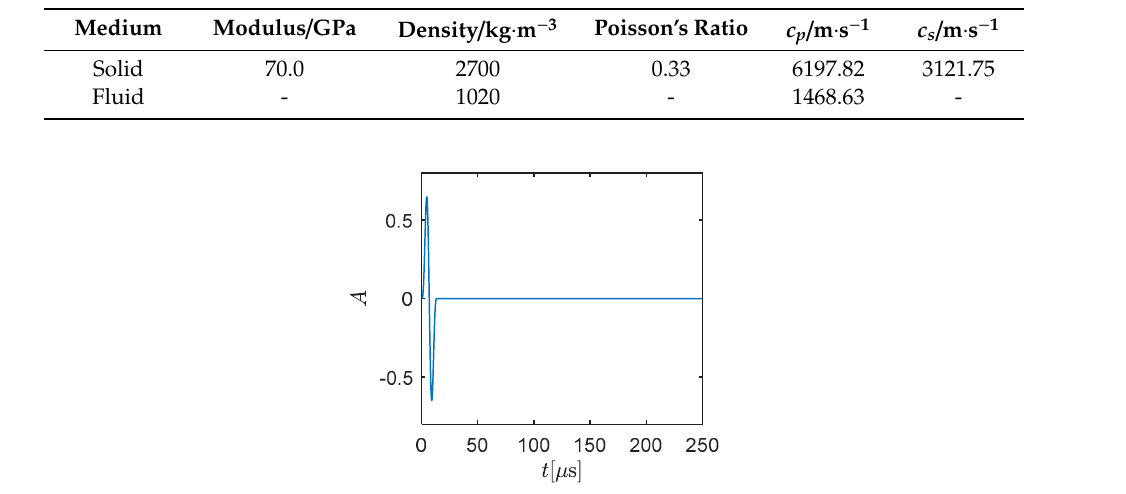
Table 3. Parameters of the regular regions.